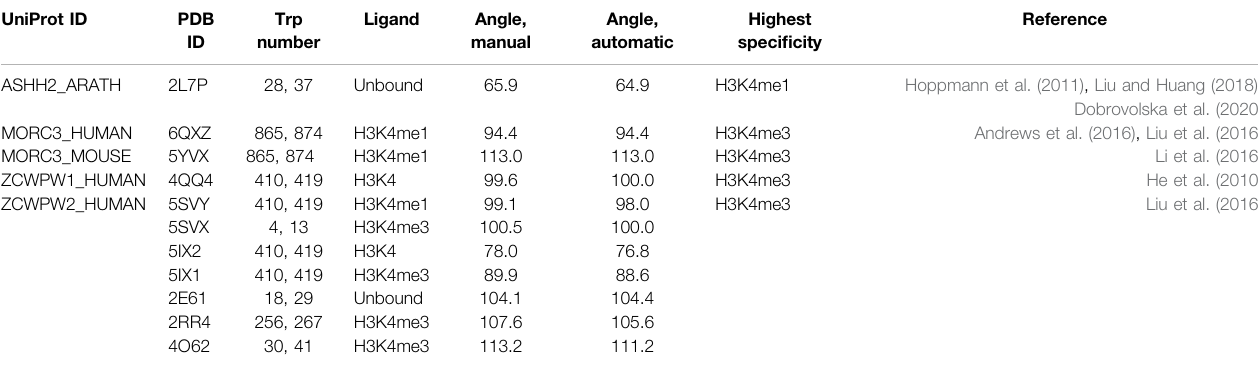
TABLE 1 | Angles between tryptophan side chains forming the binding pocket. Tryptophan angle measurements were performed manually with Screen Scales from Talon Designs LLP and automatically by fi tting a plane through the coordinates of the carbon and nitrogen atoms in the two tryptophan side chains and solving the angle betweenthetwoplanes.TheTrpnumbersrefertotheresiduenumberingusedinthecorrespondingPDBID.Ifmorethanonechainisavailableinthestructures,onlychainA is used for this calculation. UniProt